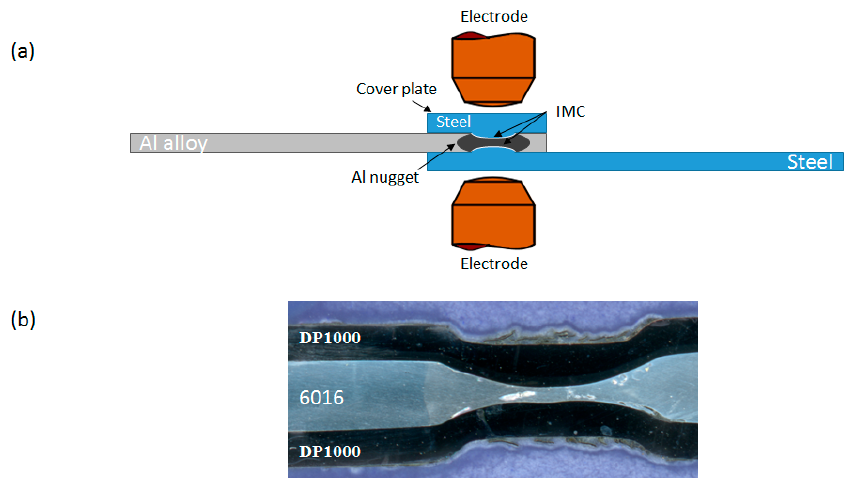
Figure 5. Resistance spot welding using a steel cover plate ( a ) and example of cover plate welding between 6016 aluminum alloy and DP1000 Steel ( b ).